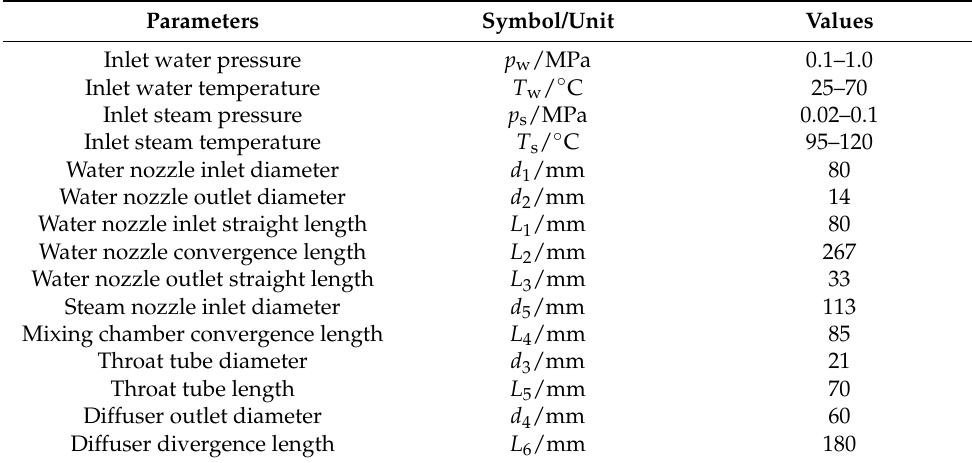
Table 2. Parameters of steam inlet, water inlet and injector configuration.